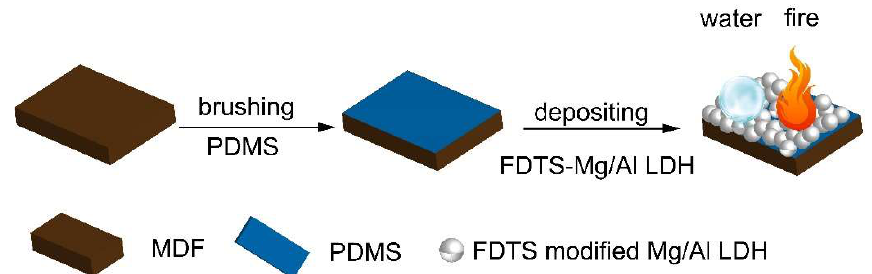
Figure 1. Schematic illustration of the procedure to fabricate PDMS@FDTS-Mg/Al LDH coating on the MDF surface. PDMS: Polydimethylsiloxane; FDTS: 1H, 1H, 2H, 2H-perfluorodecyltrichlorosilane; LDH: Layered double hydroxide; MDF: Medium density fiberboard.